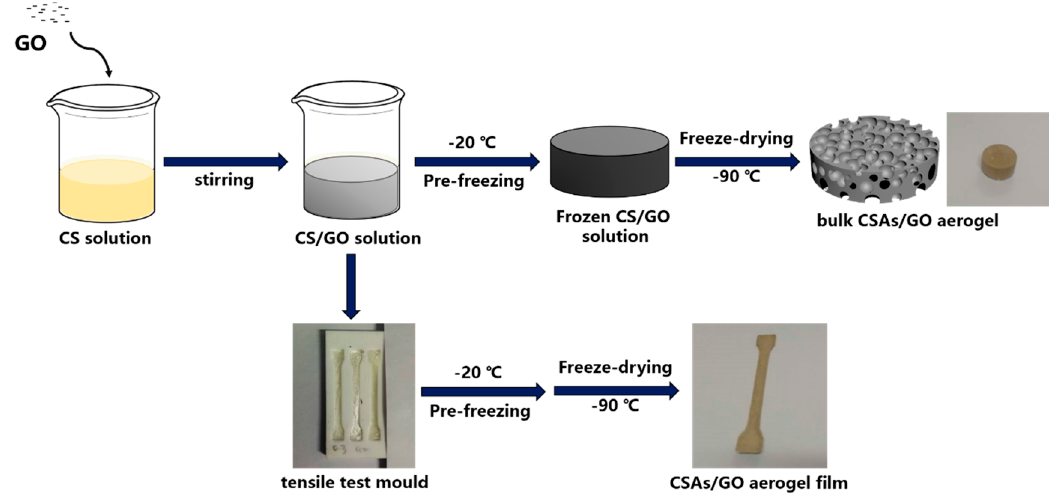
Figure 1. Schematic illustration showing the whole process for the preparation of CSAs / GO.